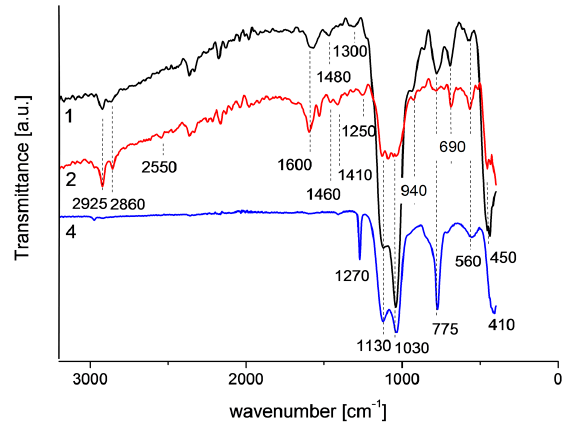
Figure 8. FTIR spectra of the powder obtained from sols used to coating preparation (1: powder from sol used to prepare coating 1; 2: powder from sol used to prepare coating 2; and 4: powder from sol used to prepare coating 4).